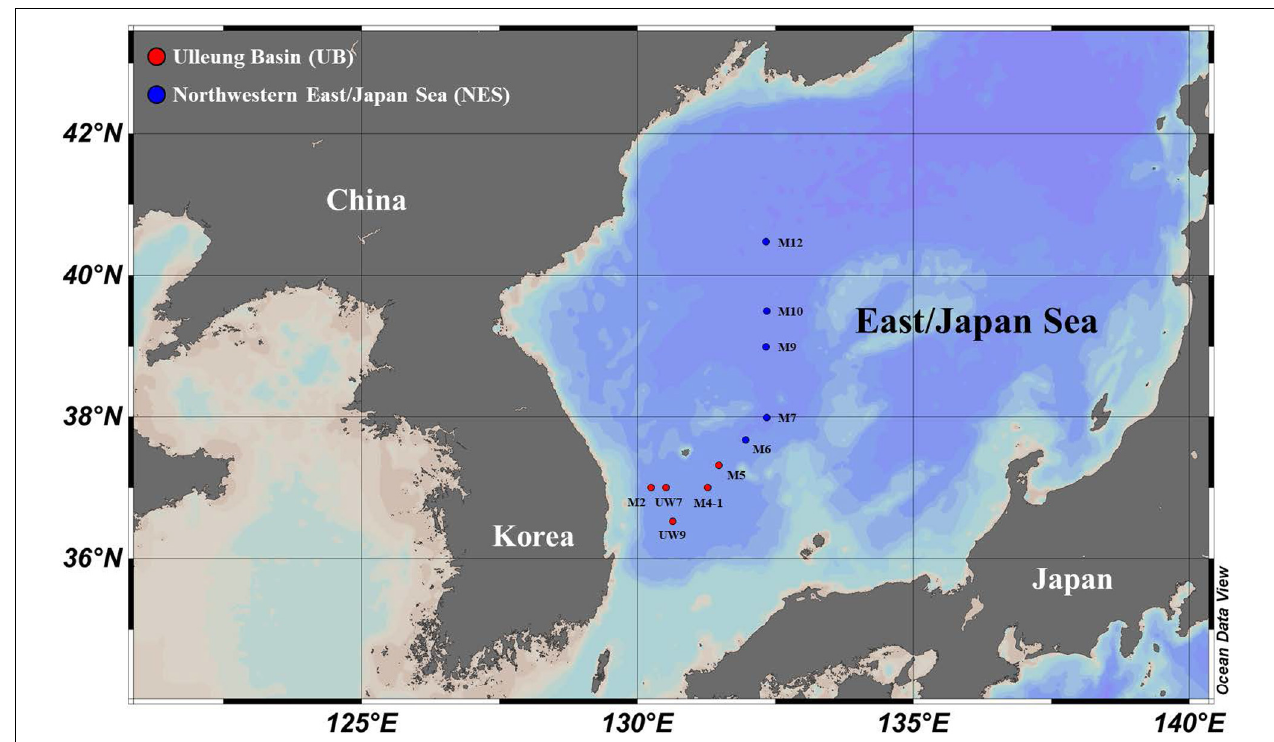
FIGURE 1 | Locations of sampling stations for primary productivity and biochemical composition measurements in the western EJS in 2016.